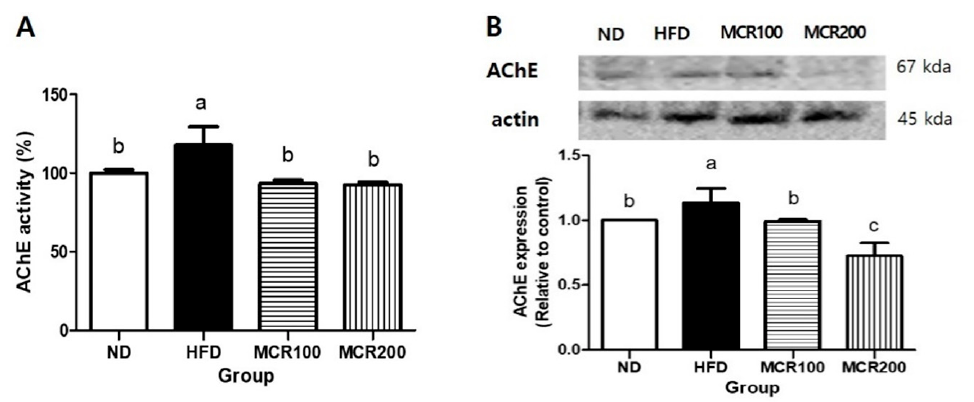
Figure 5. The effect of Mori Cortex radicis extract (MCR) on HFD-induced acetylcholinesterase (AChE) activity. ( A ) AChE activity and ( B ) its protein expression. Mice were fed ND or HFD with or without MCR (100 or 200 mg/kg b.w.) for 14 weeks. AChE activity and protein in brain tissues were measured using an ELISA kit by western blotting, respectively. Results are presented as means ± SDs ( n = 8). Statistical significance was accepted for p values < 0.05. Small letters indicate significantly different from other groups.